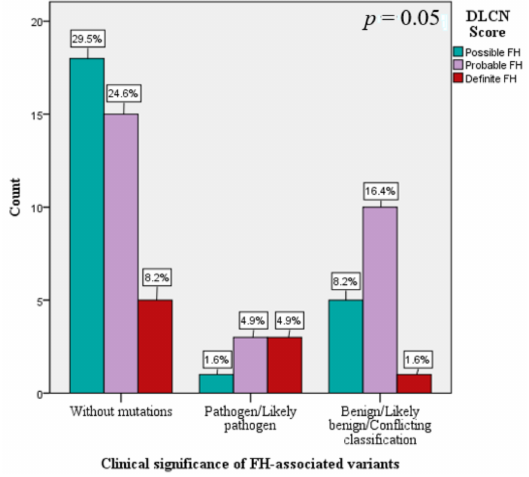
Figure 5. The frequency of mutations and DLCN